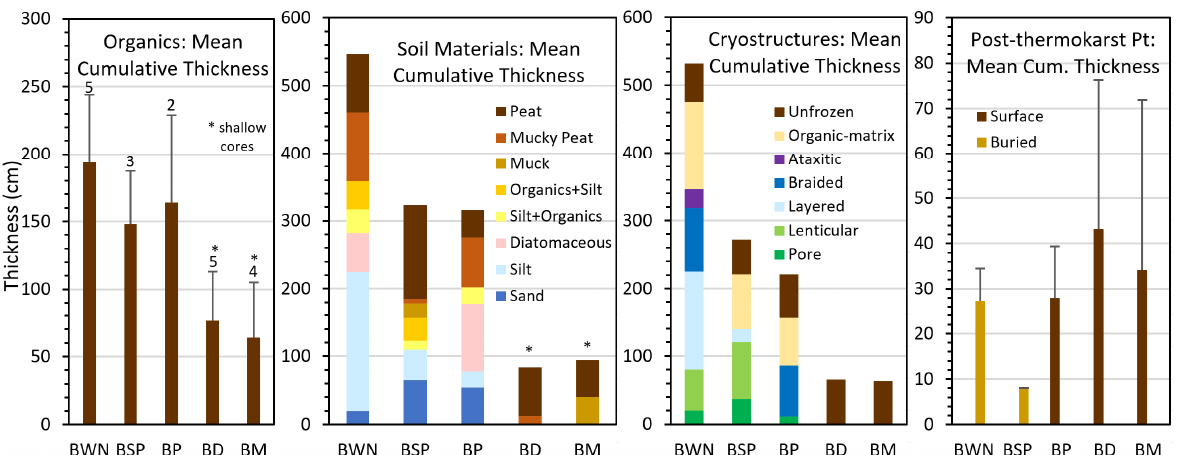
Figure 11. Mean (±SD) cumulative thickness (summed by core) of organics, soil materials, cryostruc- tures, and post-thermokarst peat by ecotype. Ecotypes are BWN—black spruce bog, BSP—post-fire scrub bog, BP—partially vegetated bog (new permafrost), BD—ericaceous bog, and BM—sedge- Sphagnum bog.